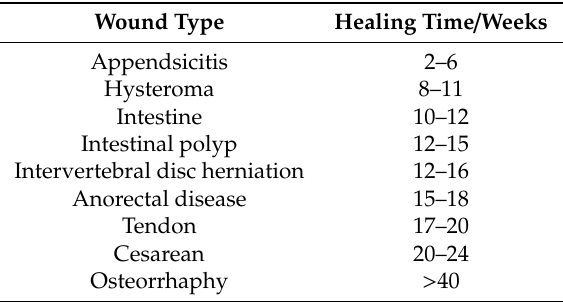
Table 1. Healing time of di ff erent types of